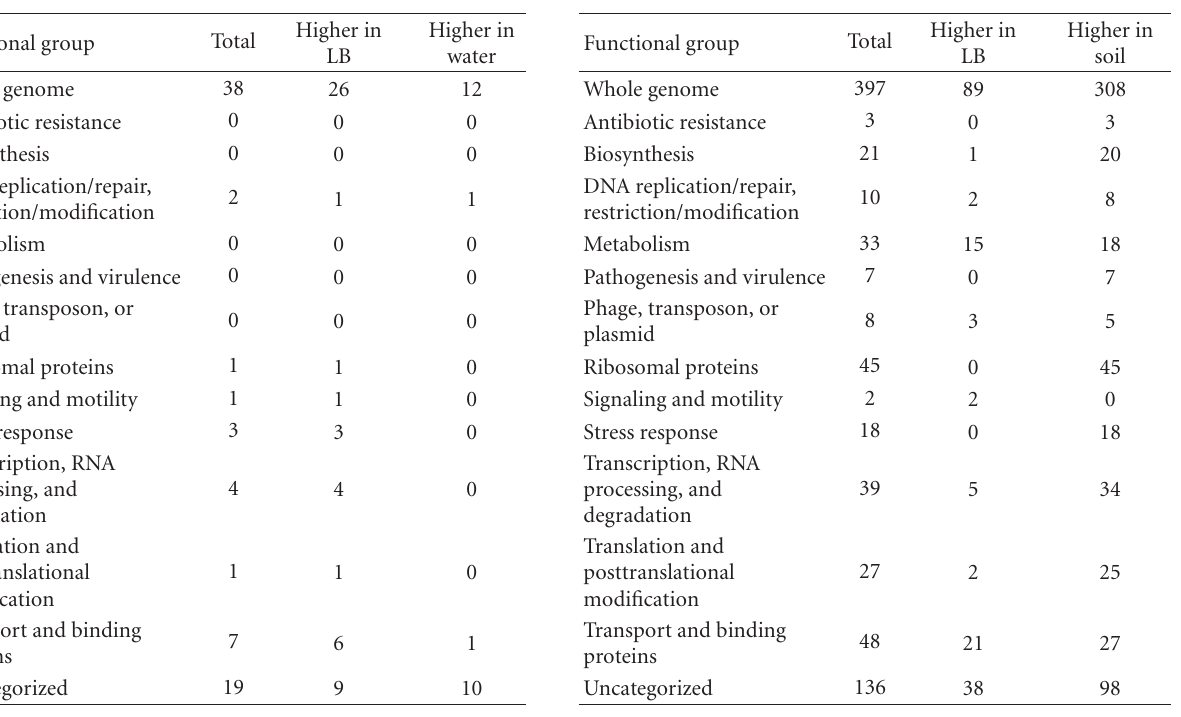
Table 1: Functional groups di ff erentially expressed between growth in LB and growth in sterile stream water.